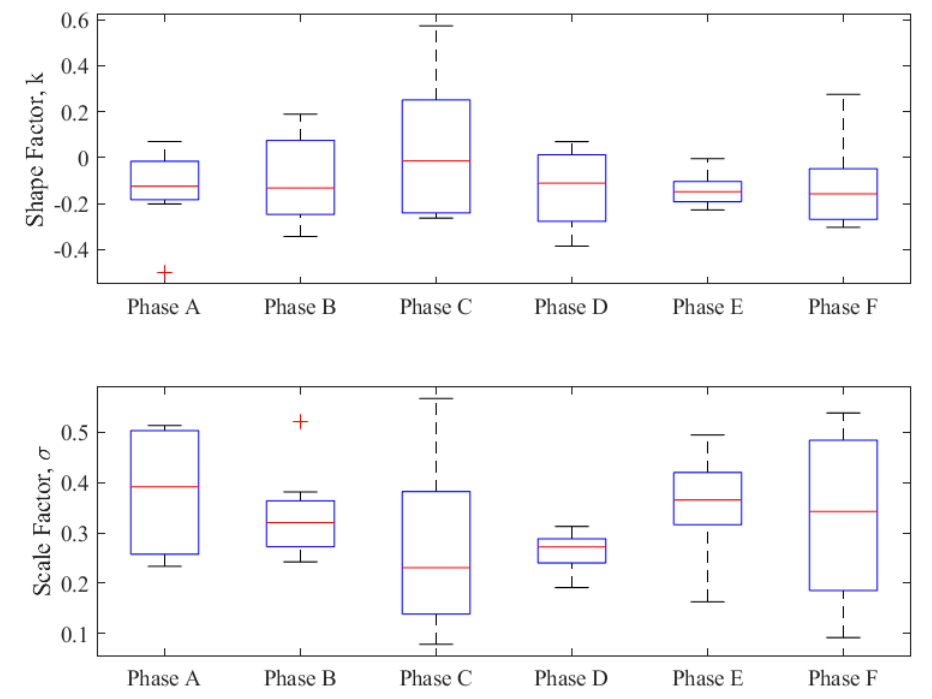
Figure 17. Boxplots showing the spread of scale and shape factors between all phases of testing.